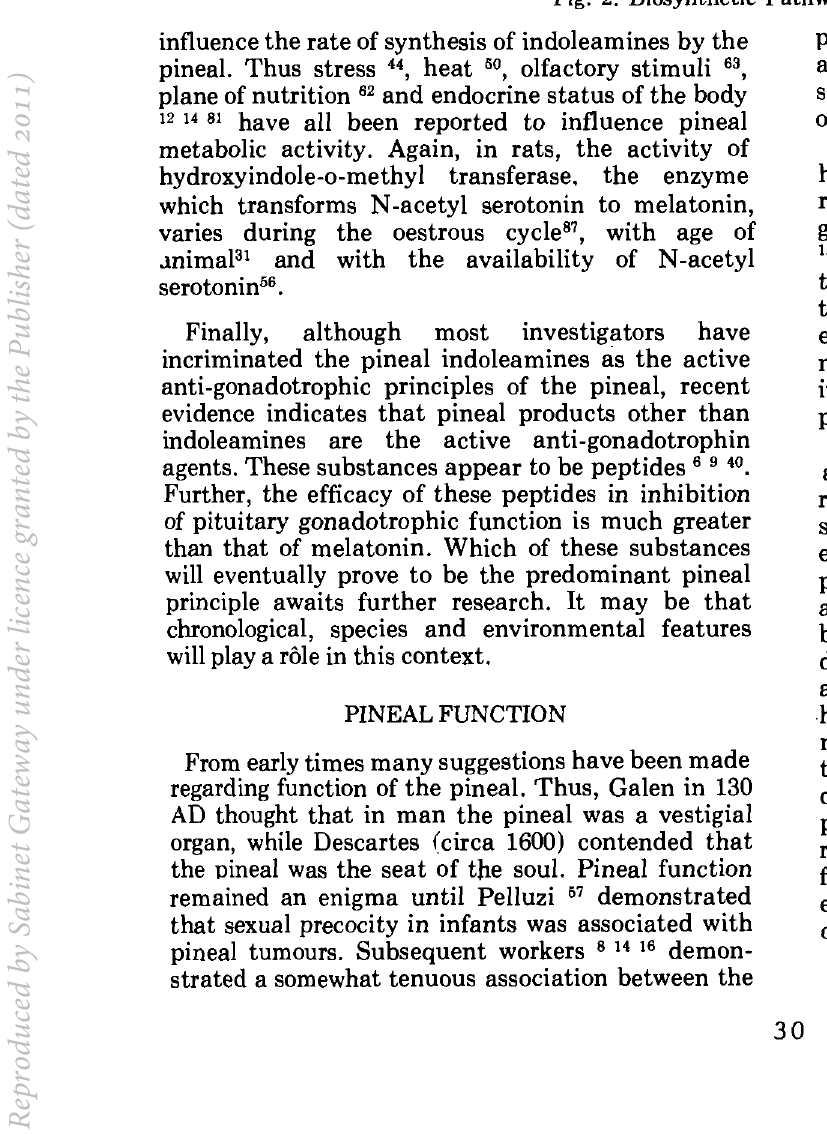
Fig. 2: Biosynthetic Pathway of